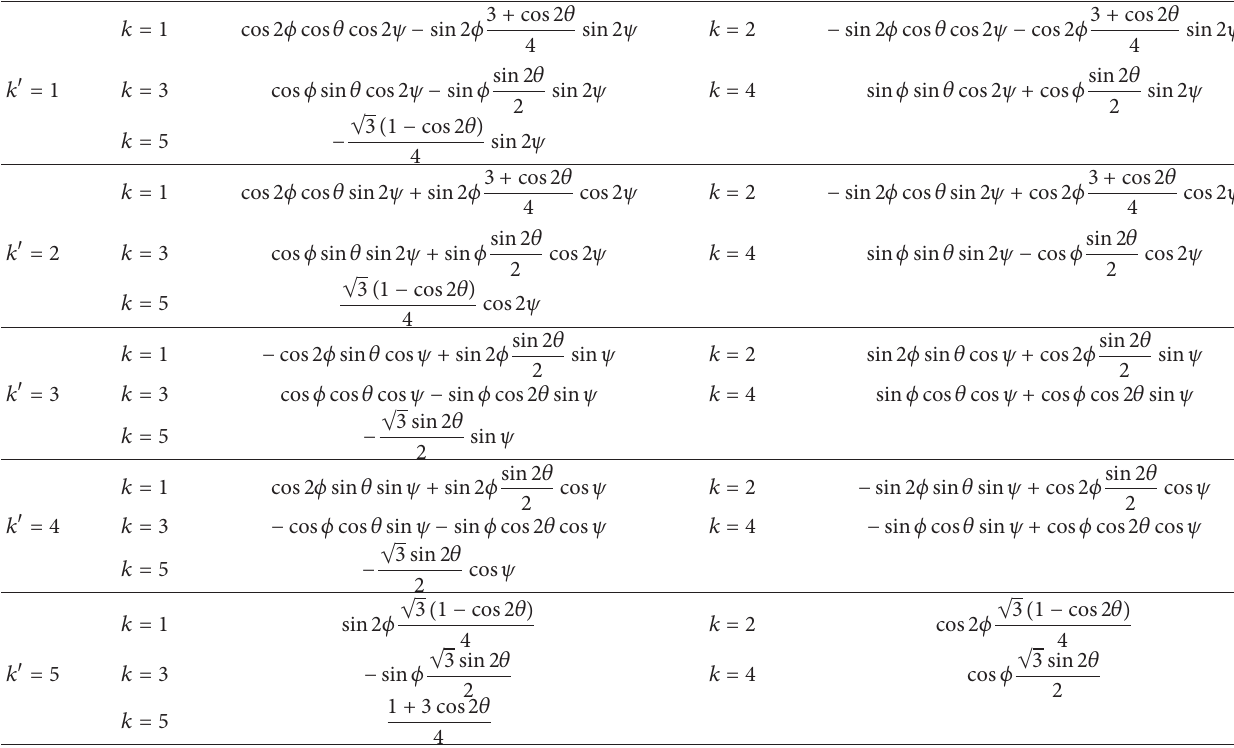
̃ R (𝜙,𝜃,𝜓) for Euler angles ( 𝑘,𝑘 󸀠 ∈ {1,2, 3, 4,5} ≡ 𝑚,𝑚 󸀠 ∈ {1,3, 4, 6, 8} ). Table 9: Expressions of 𝑘,𝑘 󸀠